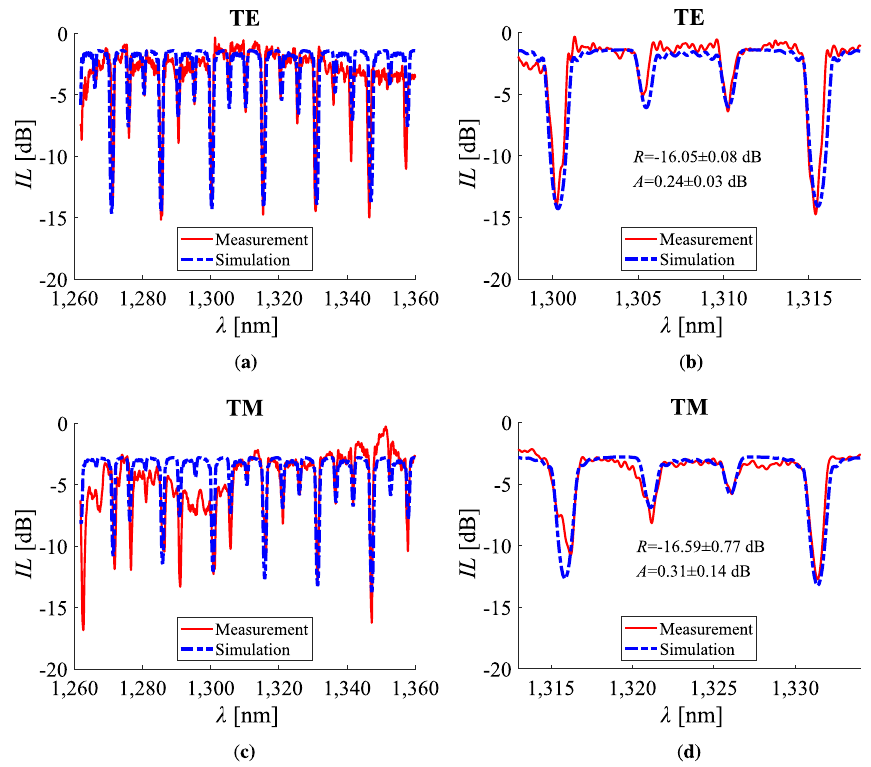
Figure 7. Transmission spectrum for a normalised device of seven blocks, (a) , (c) in the O-band and (b) , (d) in a restricted range of wavelengths, for TE and TM polarisations, respectively. The geometrical parameters of the device are summarised in Tables 1 and